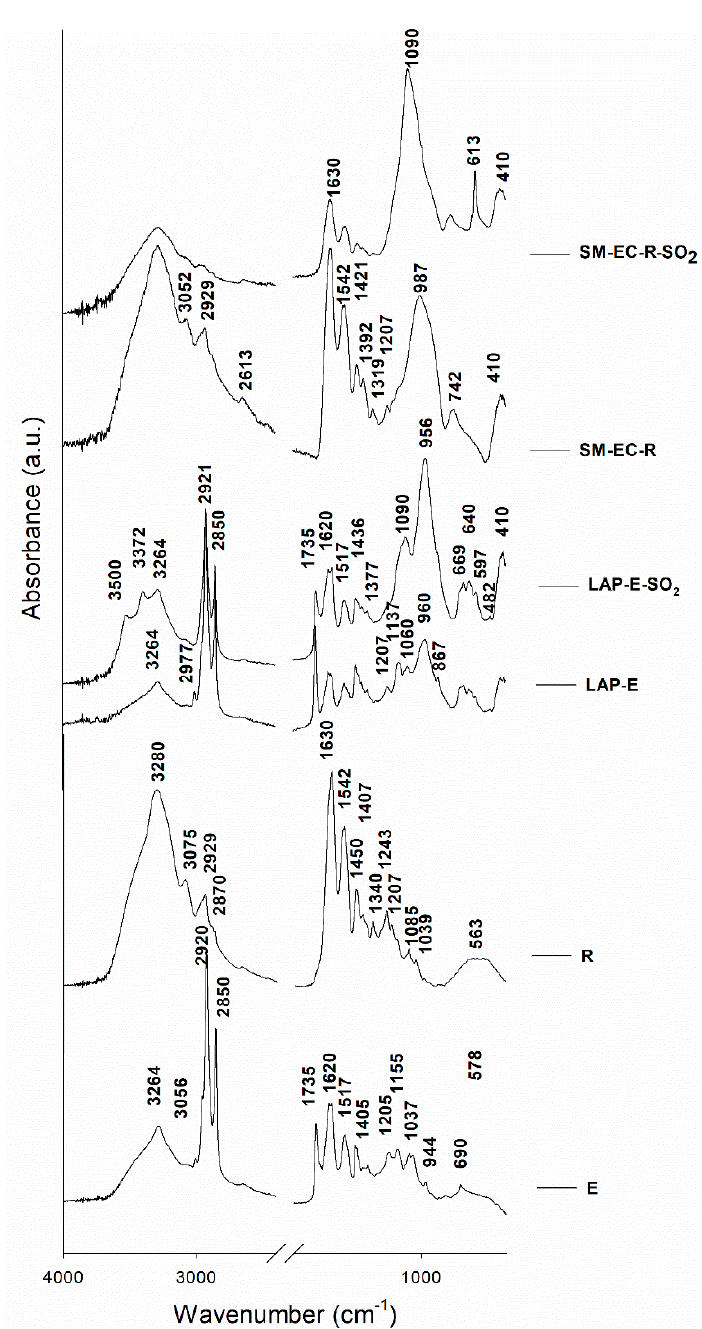
Figure 4. Attenuated Transmittance Reflectance–Fourier transform infrared spectroscopy (ATR-FTIR) (absorbance) spectra of the most representative paint and binder mock-ups in this research. Check Table 1 to better follow the paints labeling. –SO 2 shows the aged samples.